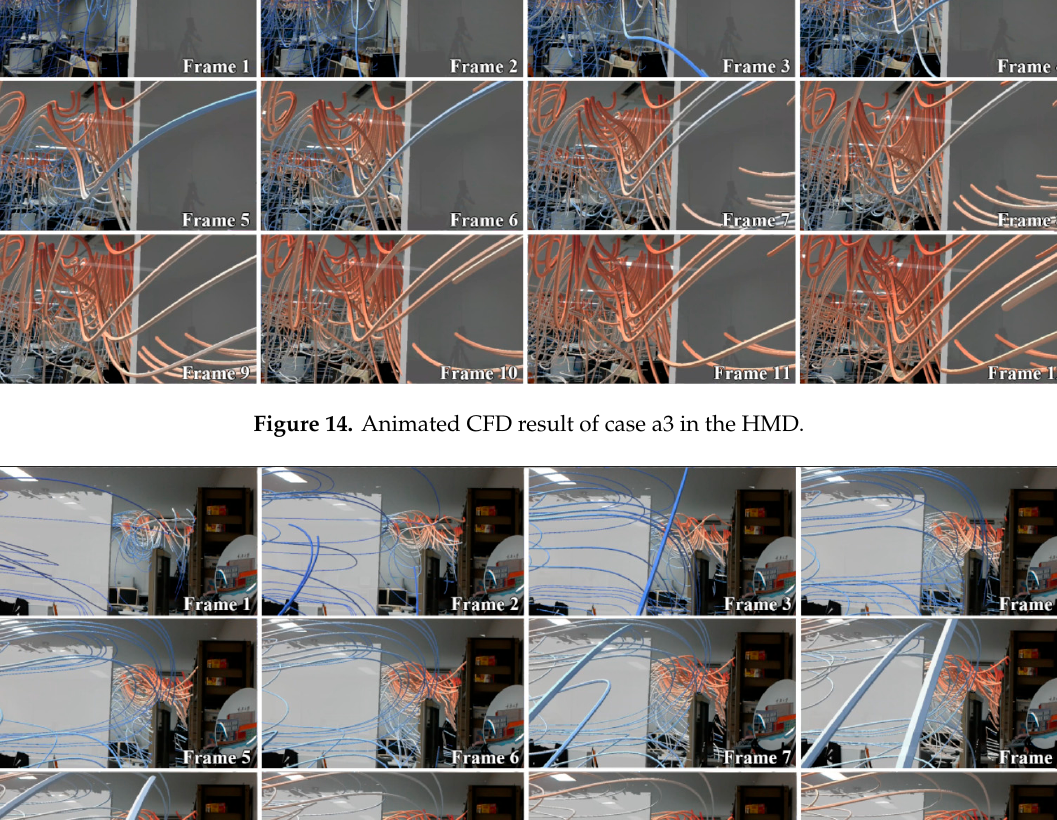
Figure 16. Animated CFD result of case c3 in the HMD.